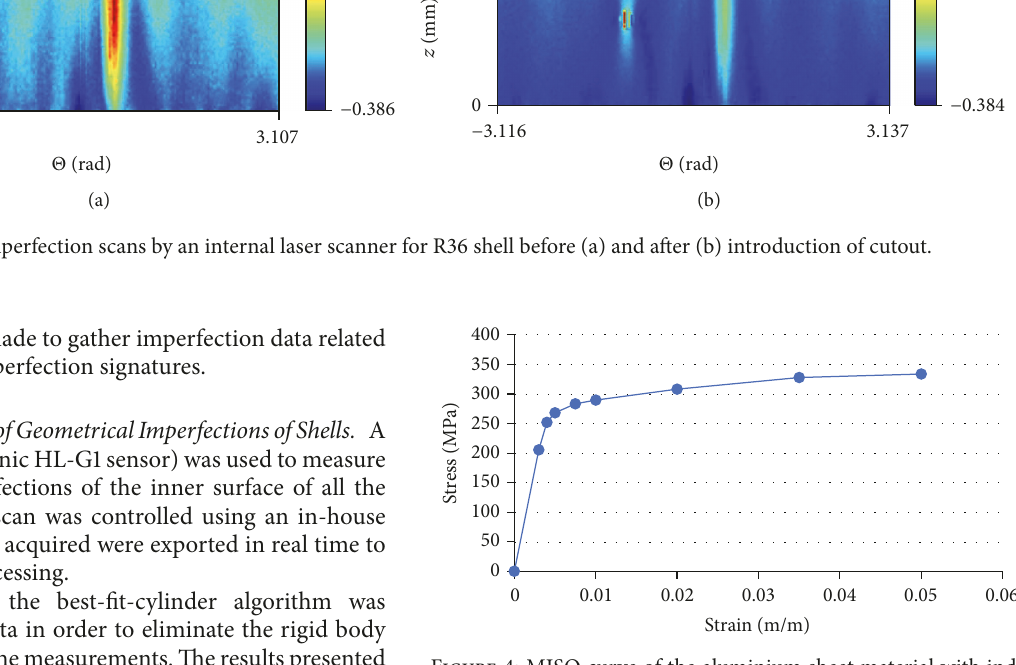
Figure 4: MISO curve of the aluminium sheet material with indi- cated experimental stress-strain data points used for its construc-